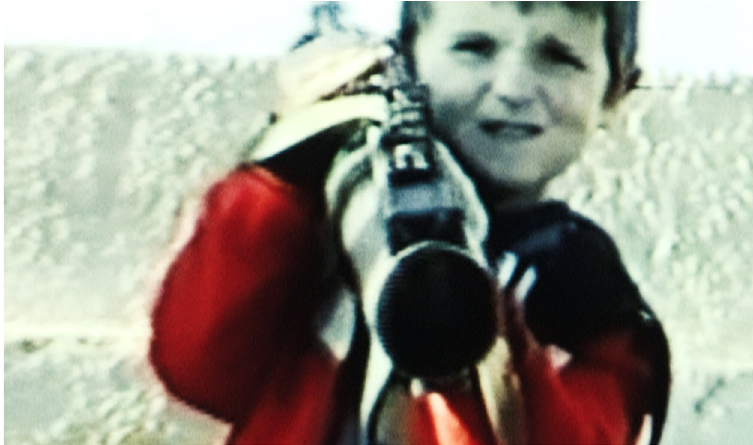
Fig. 1. Still from the documentary-poetry film Bridges <Bosnia 20>